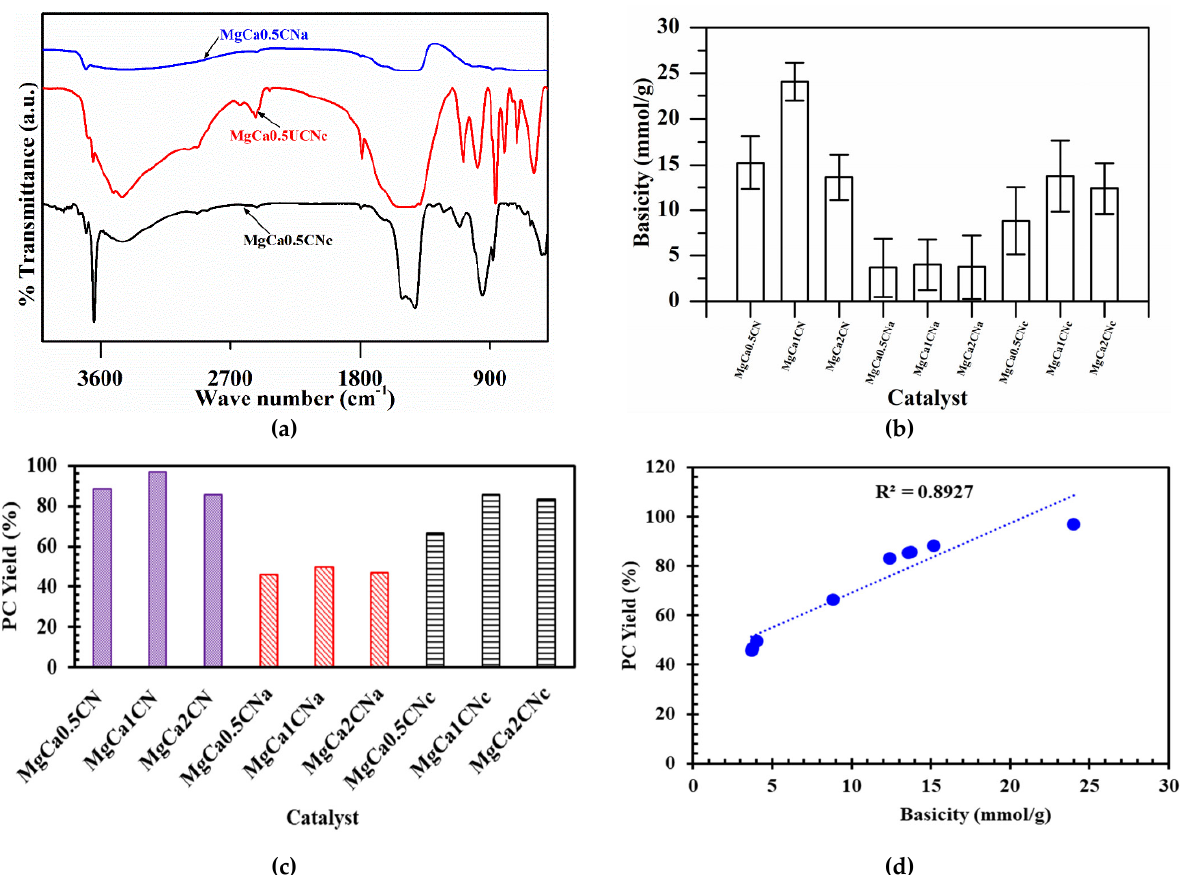
Figure 4. ( a ) FTIR analysis of calcined and uncalcined CaO ‐ MgO. ( b ) Basicity of the catalysts. ( c ) Effects of Mg/Ca ratio and precipitating agents on the yield of PC; conditions: catalyst 1 wt.%, reaction time 3 h, PG/urea ratio 4:1, reaction temperature 160 °C. ( d ) Effect of basicity on PC yield.